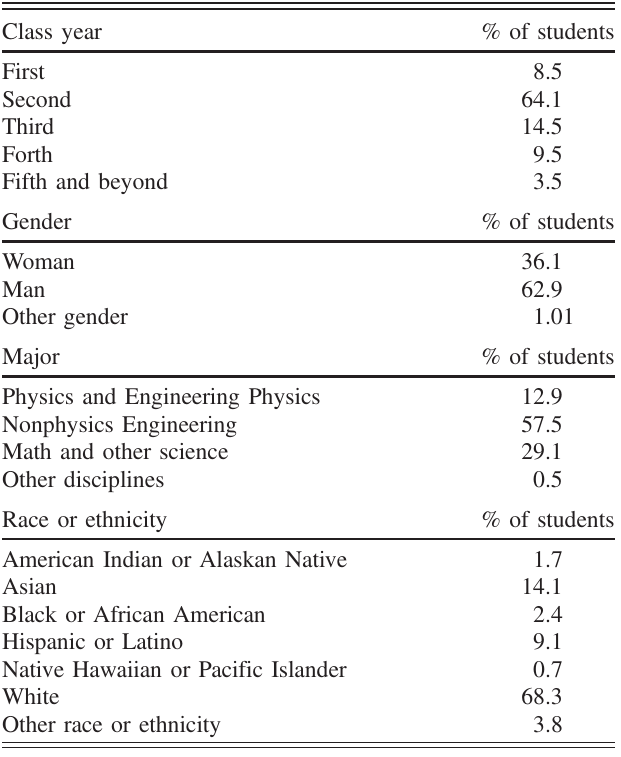
TABLE I. Self-reported demographic data of 407